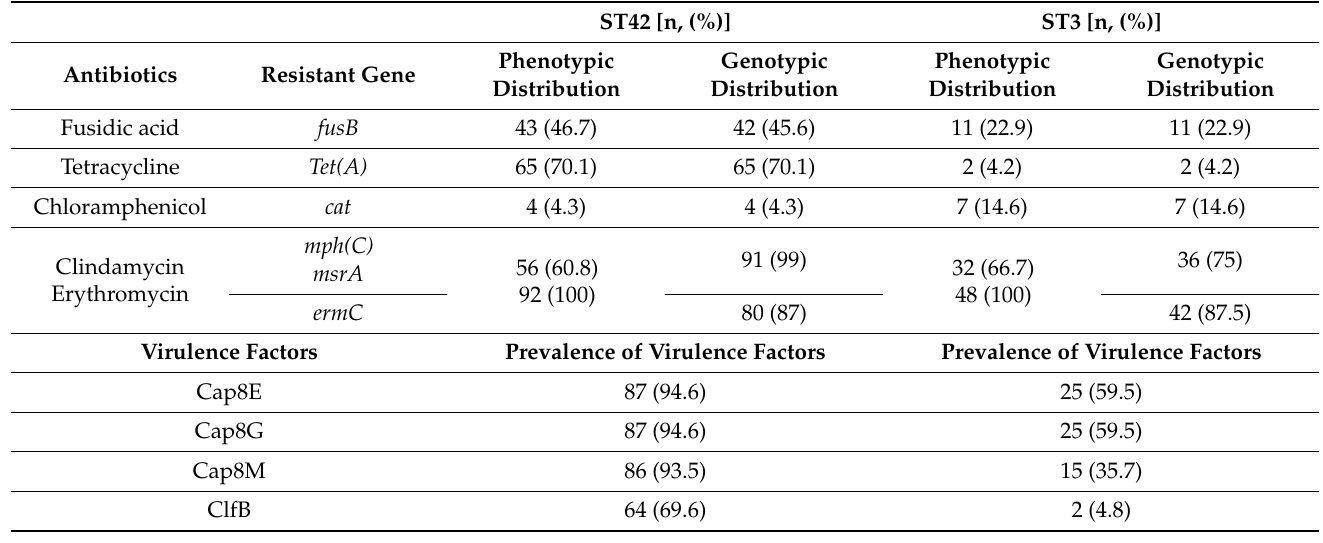
Table 2. Distribution of antibiotic-resistant genes and virulence factors among clinical collected 92 ST42 and 48 ST3 strains.